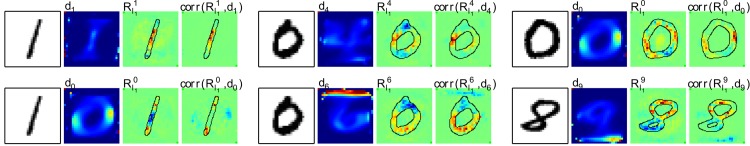
Each quadruple shows: on the leftmost the input digit; on the middle left the class specific pixel-wise density ratios d
k (Eq (65)) for the digit class k for which the pixel-wise decomposition is computed; on the middle right the pixel-wise decomposition R
(1) for that digit and the digit class k; on the rightmost the correlation between d
k and the pixel-wise decomposition R
(1).When considering a digit from class i and a pixel-wise decomposition from class k ≠ i, it is observable that the pixel-wise decomposition shows frequently highly positive activations on pixels of the digit from class i which have high relative density d
k for the digit class k ≠ i.